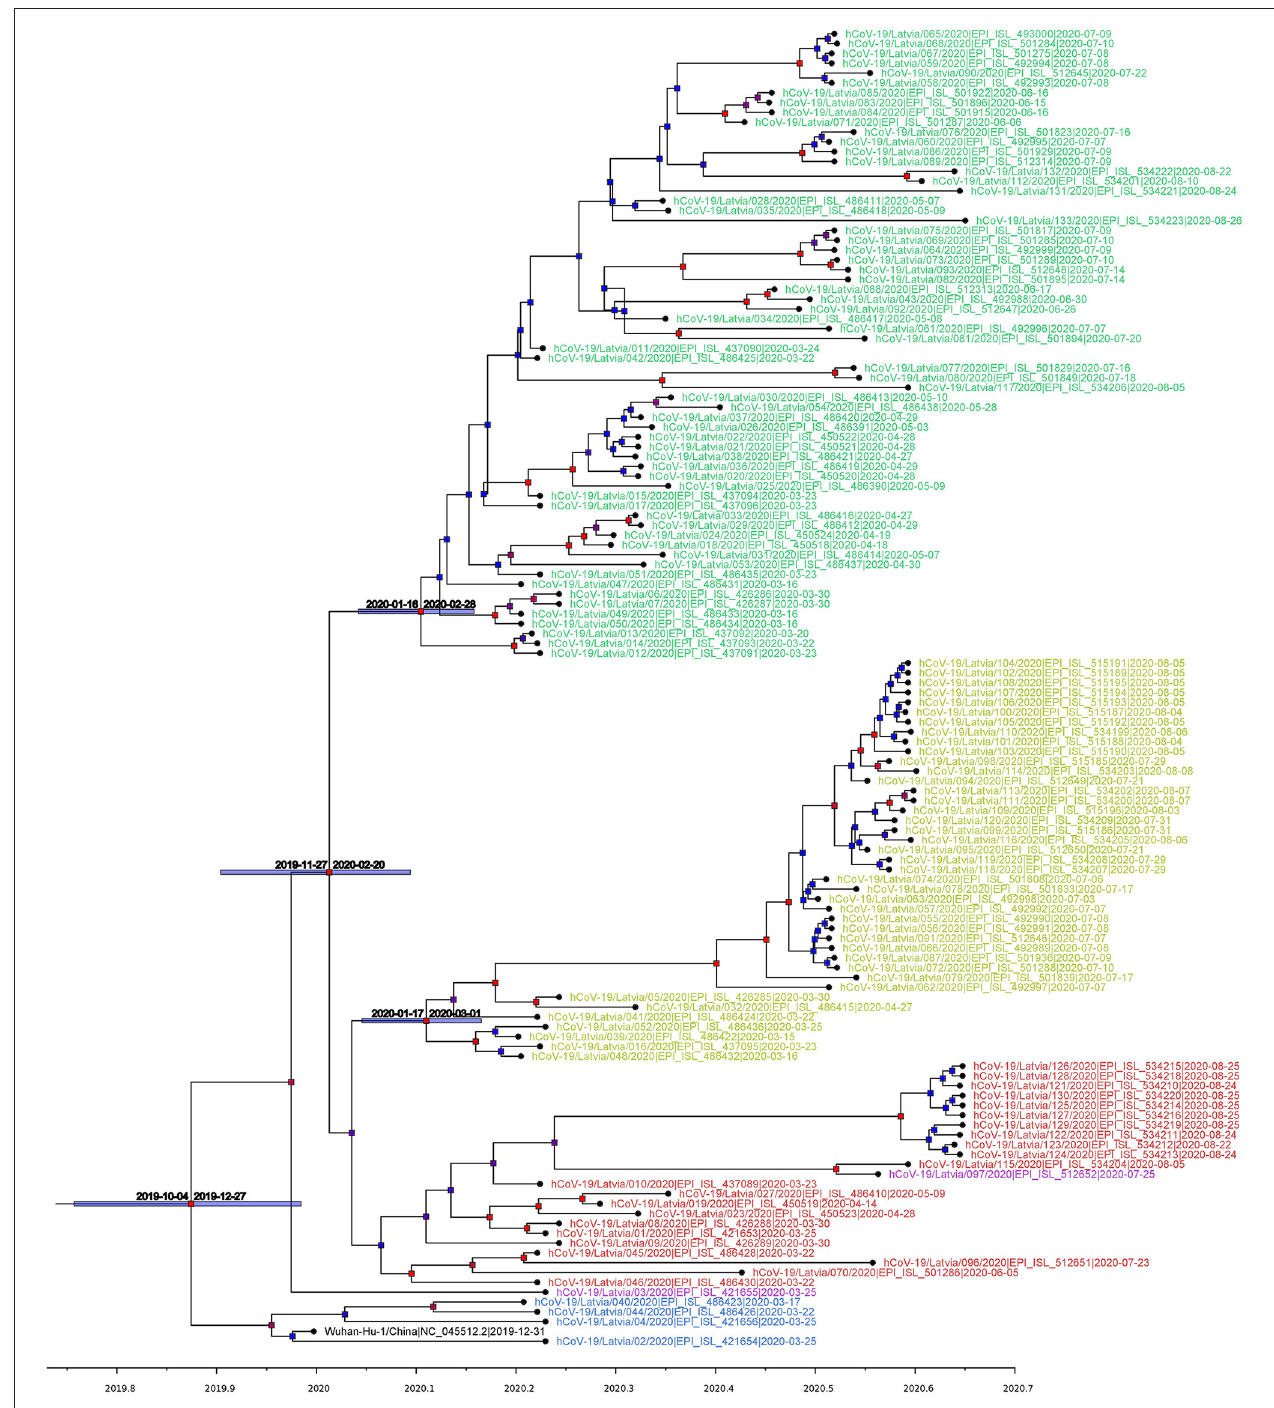
FIGURE 3 | Maximum clade credibility tree (mean node heights) estimated from the completely sequenced Latvian isolates ( n = 133) and Wuhan-Hu-1 isolate. Node labels are colored according to the GISAID major clade of particular isolate, as follows: green, GR; yellow, GH; red, G; blue, L; purple, O (other); black, Wuhan-Hu-1 reference sequence. The tree is time scaled and axis represents time in a decimal year notation (1 months is ∼ 0.08333 of a year and 1 day is ∼ 0.00274 of a year). Nodes are colored according to their respective posterior probabilities in gradient from blue (lowest value) to red (highest value). Dated node bars represent 95% highest posterior density intervals and are shown for the selected